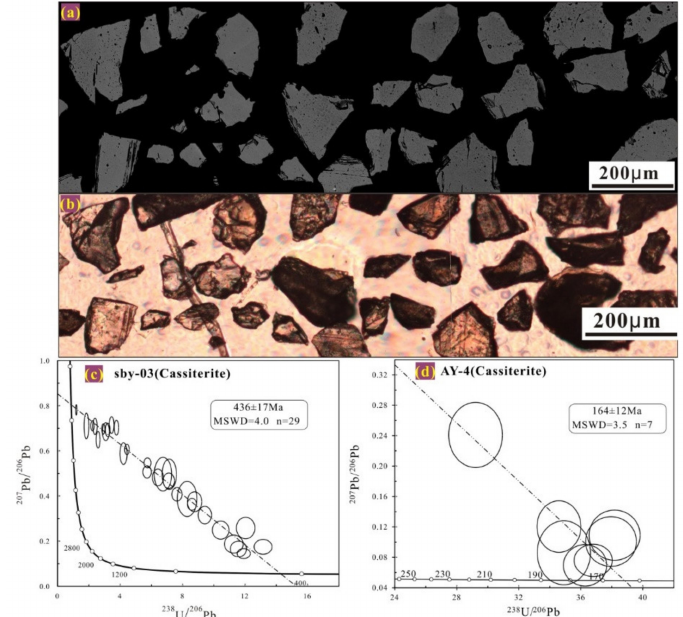
Figure 12. Tera–Wasserburg diagram for the external standard and cassiterite from the Sanbao deposit: ( a ) the BSE image of cassiterite; ( b ) transmitted light of cassiterite; ( c ) Tera–Wasserburg diagram for cassiterite sample sby-03; ( d ) Tera–Wasserburg diagram for the external standard (AY-4).